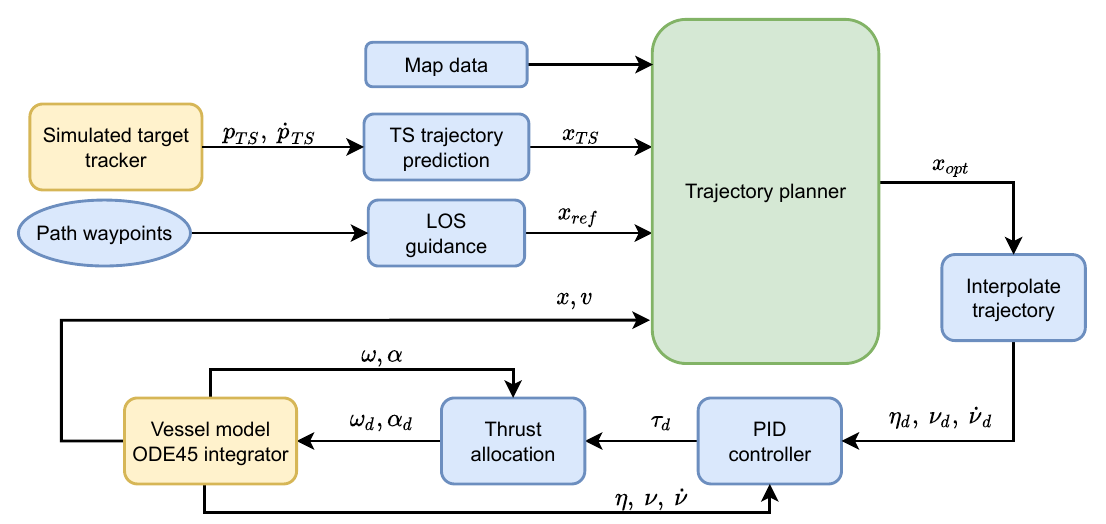
Figure 8: Guidance, navigation and control pipeline for the simulations. The internals of the green box are illustrated in Fig.